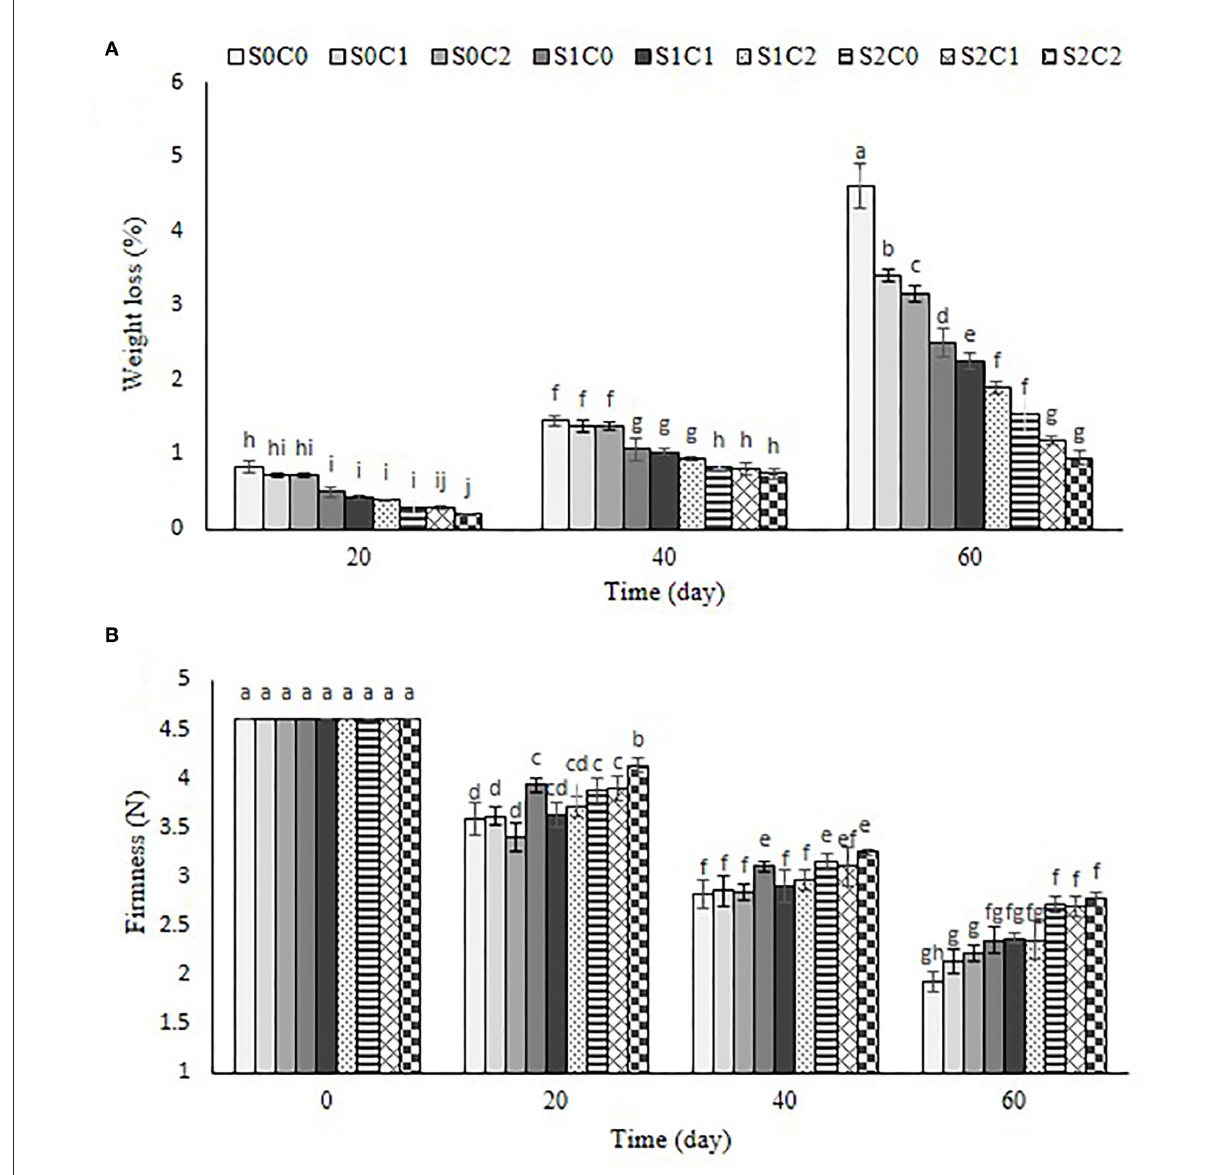
FIGURE4 Effect of foliar spraying of SA and caraway oil coating on weight loss (A) and firmness (B) during 60 d of storage at 4 ± 2 ◦ C plus shelf life (2 d, 20 ◦ C). S0C0: control, S0C1: 0.3% caraway oil, S0C2: 0.6% caraway oil, S1C0: 1.5mM Salicylic acid, S1C1: 1.5mM Salicylic acid + 0.3% caraway oil, S1C2: 1.5mM Salicylic acid + 0.6% caraway oil, S2C0: 3mM Salicylic acid, S2C1: 3mM Salicylic acid + 0.3% caraway oil, S2C2: 3mM Salicylic acid + 0.6% caraway oil. Values represent mean ± S.D of three replications. Different letters indicate significant differences at the 5%